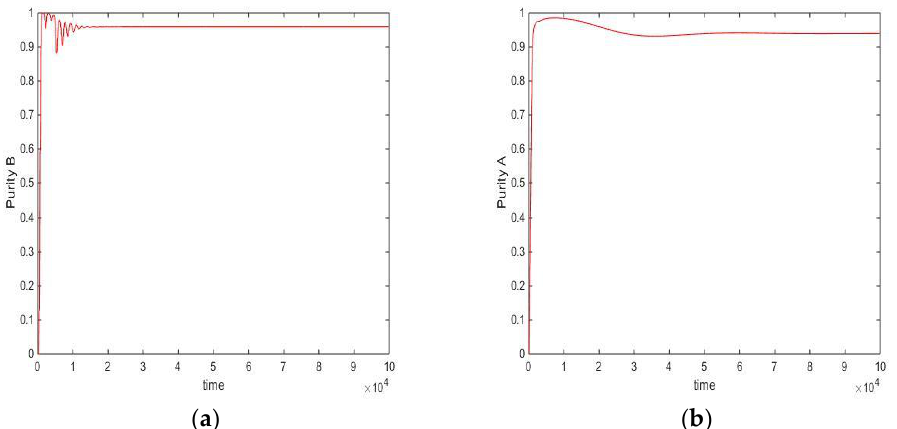
Figure 9. Control results of the third experiment (switch time = 180 s; desired A = 94%, desired B =